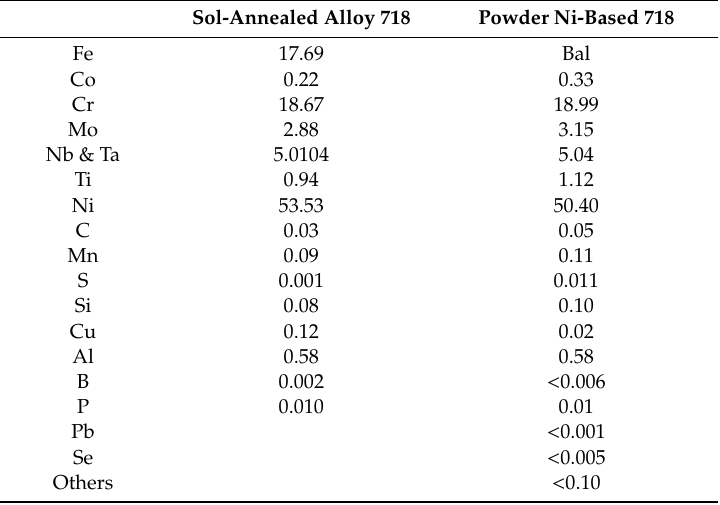
Table 1. Chemical composition (wt.%) of the base and the powder